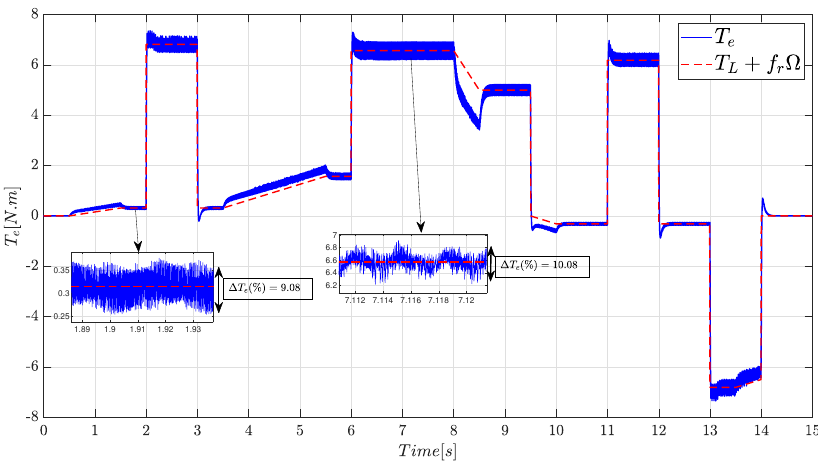
Figure 14. Torque response obtained by PI controllers and optimal currents calculations